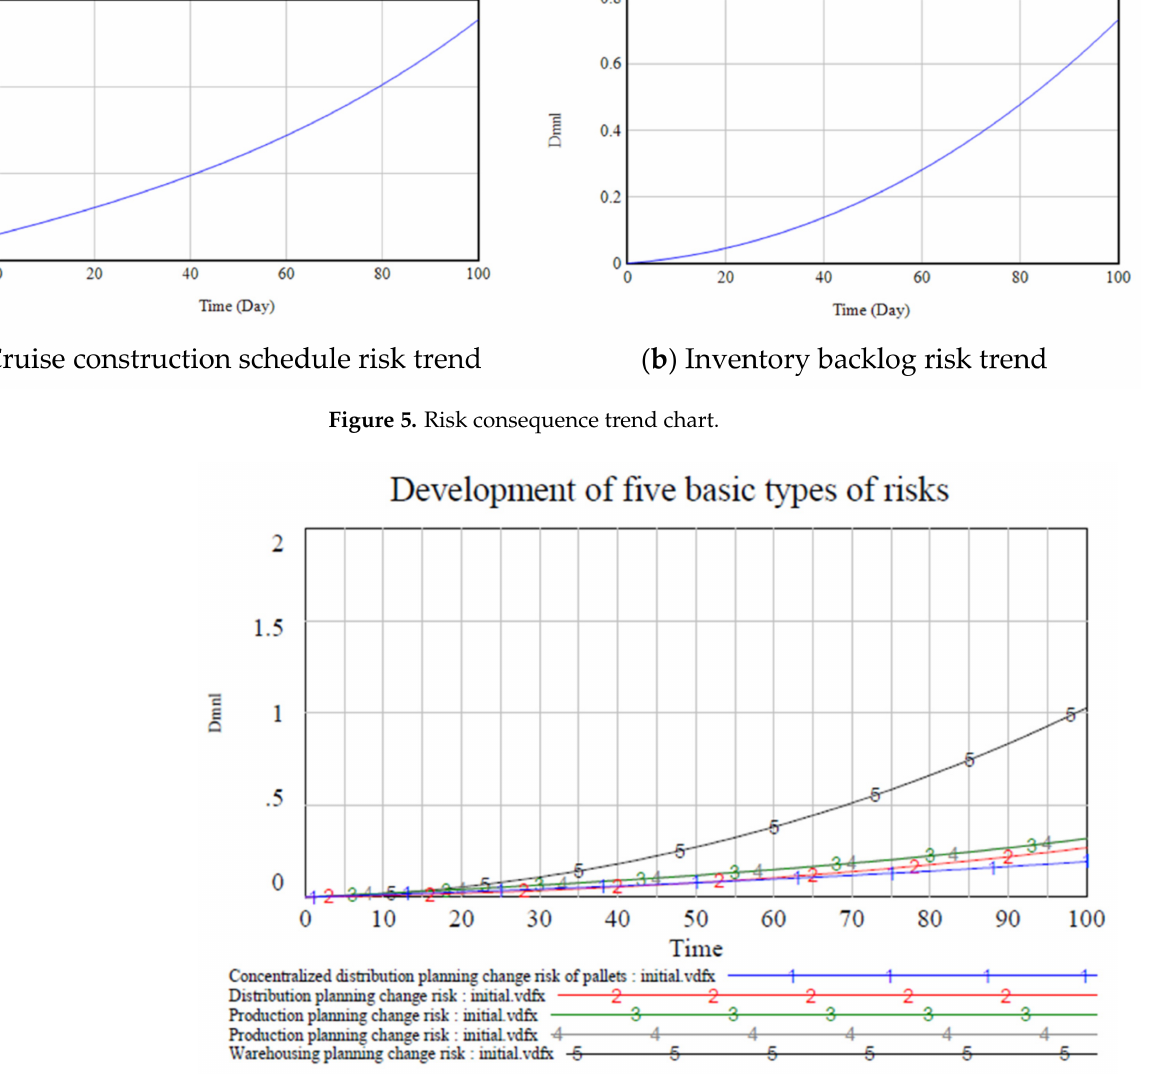
Figure 6. Trend charts of the five basic types of